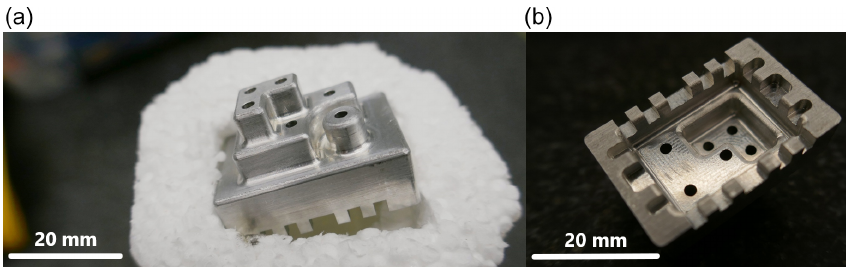
Figure 2. Used aluminium test specimen (Zierer, 2013) clamped in the Styrofoam holder in the measuring system: top view (a) and bottom view (b) .